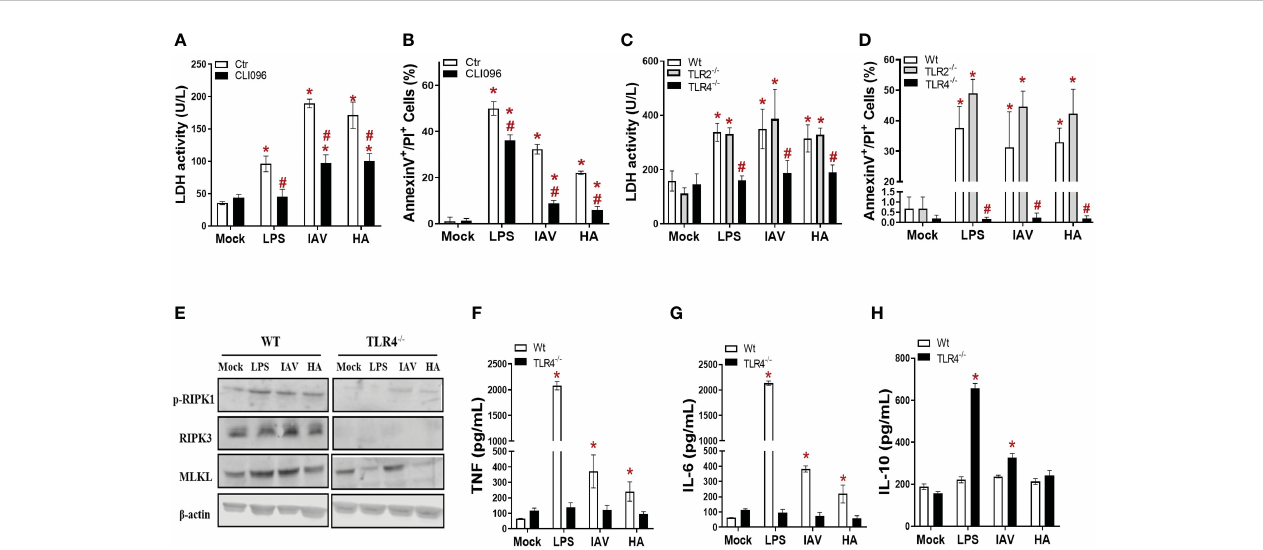
FIGURE 2 TLR4 engagement is necessary for IAV- and HA-induced in fl ammatory programmed cell death in macrophages. (A, B) BMDM cultures were pretreated with 2 µM CLI95 for 2 h, infected with IAV at an MOI of 0.25, and exposed to 10 ng/mL HA or LPS. After 24 h, LDH was measured (A) , and annexin V/PI staining was performed (B) . *P < 0.05 versus the respective control group (mock); # P < 0.05 versus the respective untreated infected/stimulated group. (C, D) BMDM cultures from WT, TLR2 -/- and TLR4 -/- mice were infected with IAV at an MOI of 0.25 and exposed to 10 ng/mL HA or LPS. After 24 h, LDH was measured (C) , and annexin V/PI staining was performed (D) . (E) The expression of p-RIPK1, RIPK3 and MLKL was detected in BMDMs by Western blotting. b -actin levels were used as a control for protein loading. The levels of (F) IL-6, (G) TNF and (H) IL-10 were measured by ELISA in the supernatant of BMDM cultures after 24 h of stimulation. * P < 0.05 in comparison to the respective noninfected groups (MOCK) and # P < 0.05 versus the respective Wt infected/stimulated group. The graphs are representative of three independent